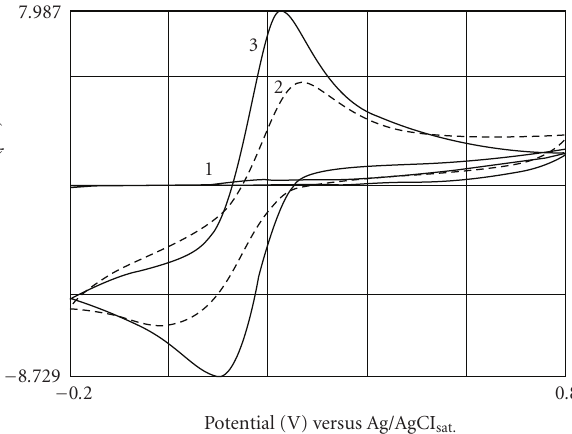
Figure 3: Cyclic voltammograms obtained for 10mM K 3 Fe(CN) 6 in 1.0 MKNO 3 (3) and in presence of 1mM gallic acid (2). The lower register (1) refers to 1.0 mM gallic acid in 1.0 MKNO 3 . Scan rate = 50 mVs − 1